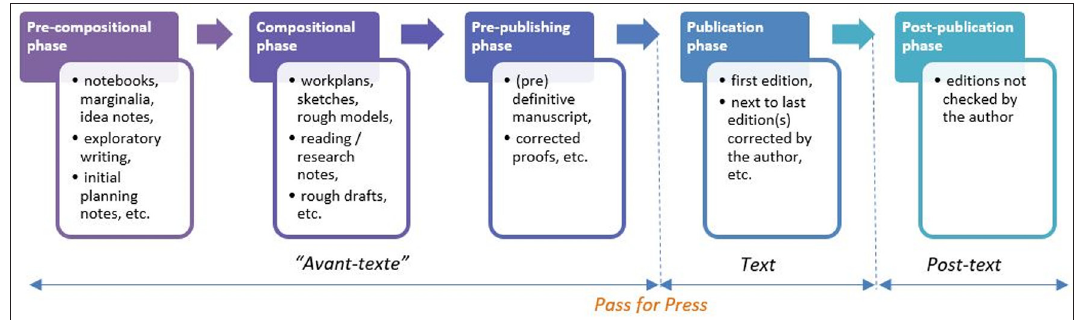
Figure 1: Chrono-typology of documents in the production of a literary work (adaptation from De Biasi and Wassenaar 1996).